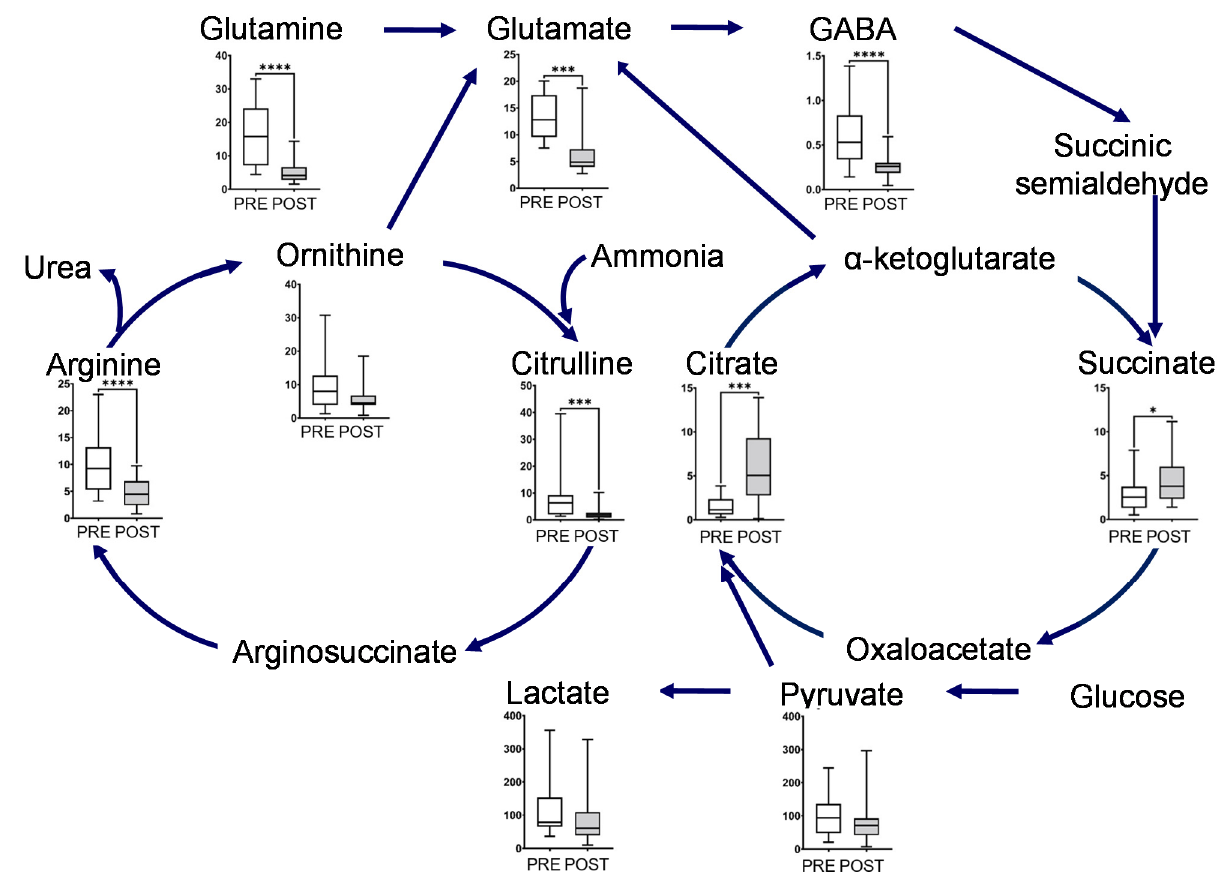
Figure 3. Box plot of metabolite concentration of individual pathways. Urea and glutamate cycle, TCA cycles, and glycolytic pathway. The horizontal bars of the box plots indicate the maximum, 75%, 50%, 25%, and minimum values of the data. The Y -axis indicates concentration ( µ mol/L). FDR-corrected **** p < 0.0001, *** p < 0.001, and * p < 0.05 by the paired Wilcoxon test.